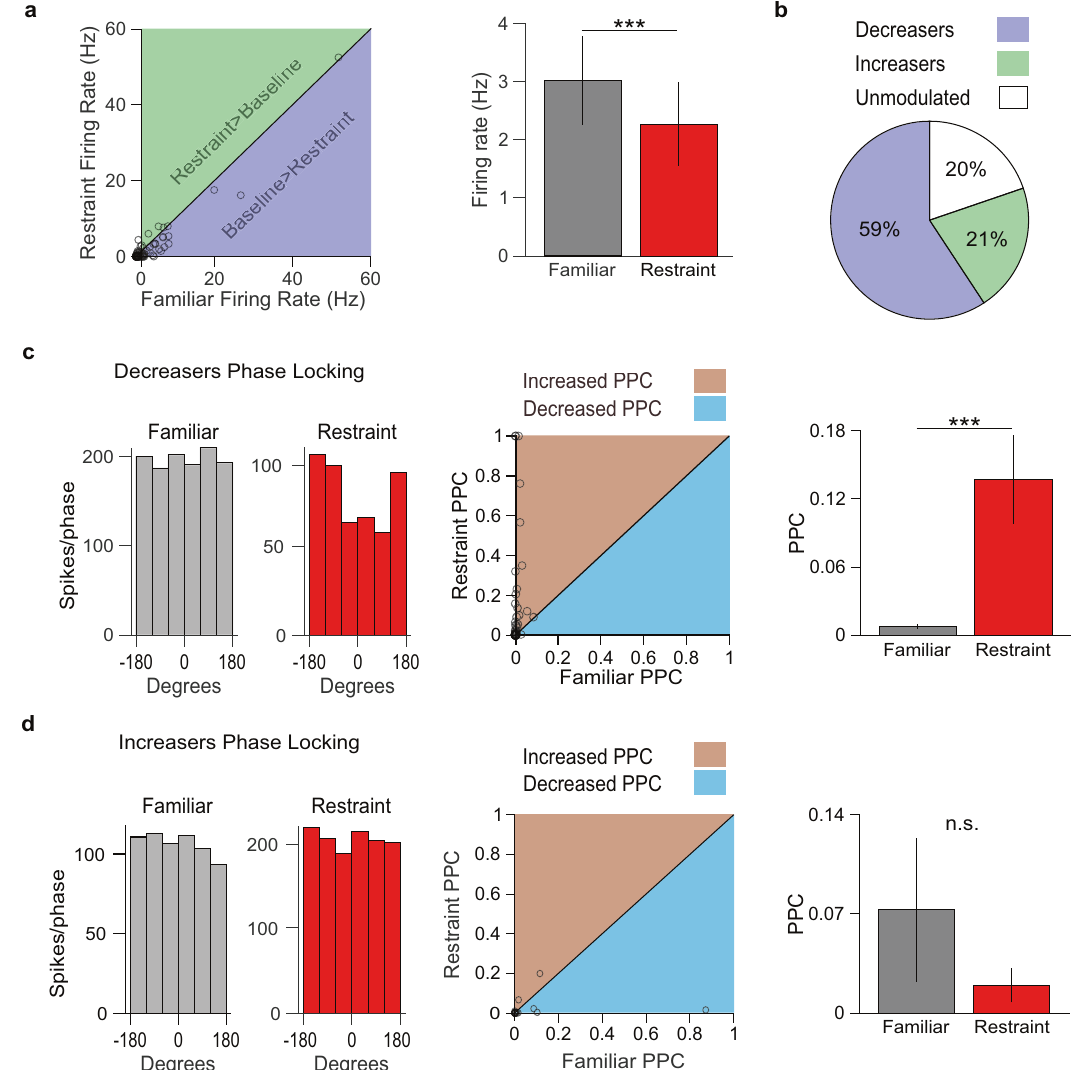
Fig. 2 Restraint-inhibited NAc units phase-lock to local low-frequency oscillations. a Left: relationship between NAc fi ring rates in familiar environment and restraint, with line of equality for reference. Right: summary of data from left panel. Restraint inhibited overall NAc neuron fi ring rate (*** P < 0.0001 two-tailed signed-rank tests, n = 81 neurons). Data are mean ± s.e.m. b Distribution of NAc neurons excited, inhibited, and unmodulated by restraint. c Left: the spike-phase relationship for example restraint-inhibited NAc neuron. The activity was uniformly distributed across 4 Hz fi ltered NAc LFP phase angles during familiar environment exploration, but phase-locked during restraint. Center: Relationship between the pairwise phase consistency (PPC) of restraint- inhibited NAc neurons during familiar environment exploration and restraint, with line of equality for reference. Right: summary of data from center panel. Restraint-inhibited NAc neurons increased phase-locking to the 4 Hz fi ltered NAc LFP during restraint (*** P < 0.0001, two-tailed signed-rank test, n = 48 neurons). Data are mean ± s.e.m. d Same as c , but with restraint-excited NAc neurons. Restraint-excited NAc neurons did not increase phase locking to the NAc LFP. ( P = 0.33, two-tailed signed-rank test, n = 17 neurons). Data are mean ±